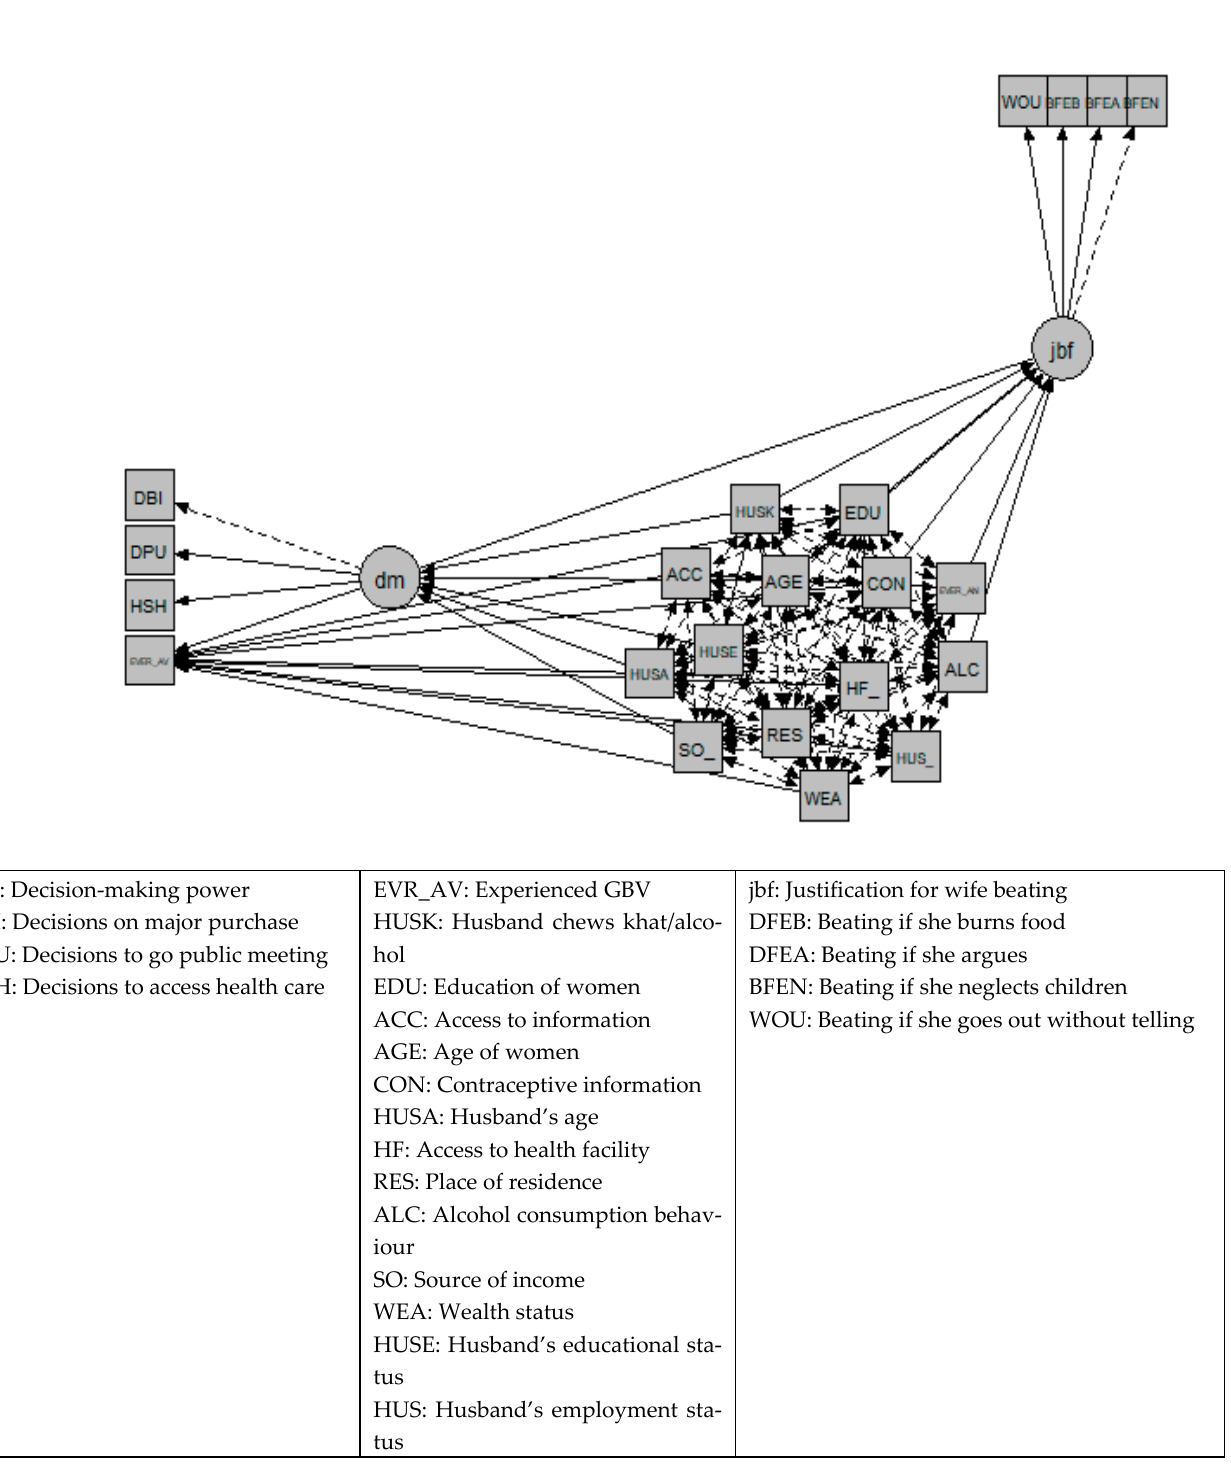
Figure 2. Structural equation model.